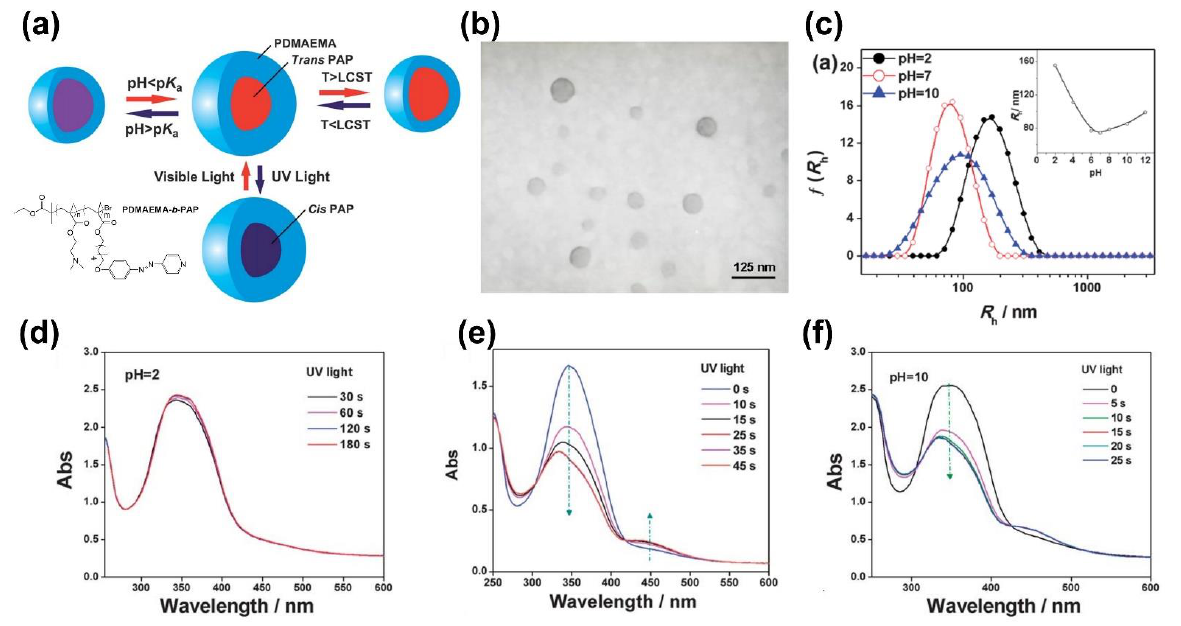
Figure 12. ( a ) Schematic representation of triple responses from the shell to the core of PDMAEMA- b - PAzPy micelles under temperature, pH, and light stimuli; ( b ) TEM image of PDMAEMA- b -PAzPy micelles (25 ◦ C and pH 7); ( c ) Z-averaged size distributions of PDMAEMA- b -PAzPy micelles at different pH values (inset: pH-dependence of hydrodynamic radius). UV/Vis absorption spectra of PDMAEMA- b -PAP micelles solution at ( d ) pH 2, ( e ) pH 7, and ( f ) pH 10 upon irradiation at 365 nm for different times (concentration: 0.15 mg mL − 1 ). Reprinted with permission from [72]. Copyright 2013, Royal Society of